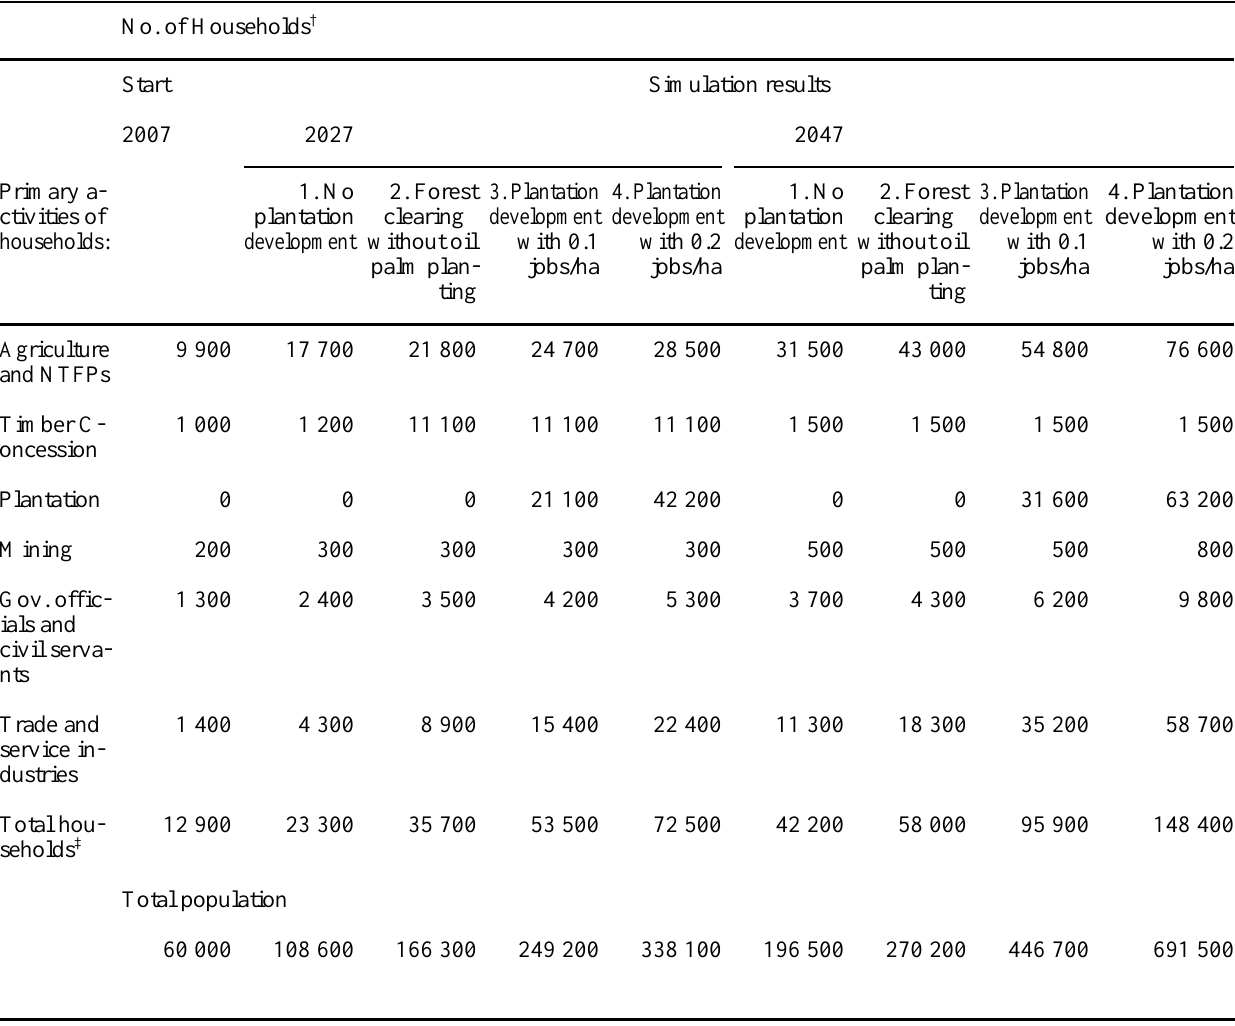
Table 2. Employment in different sectors (number of households per sector), and total population in Malinau